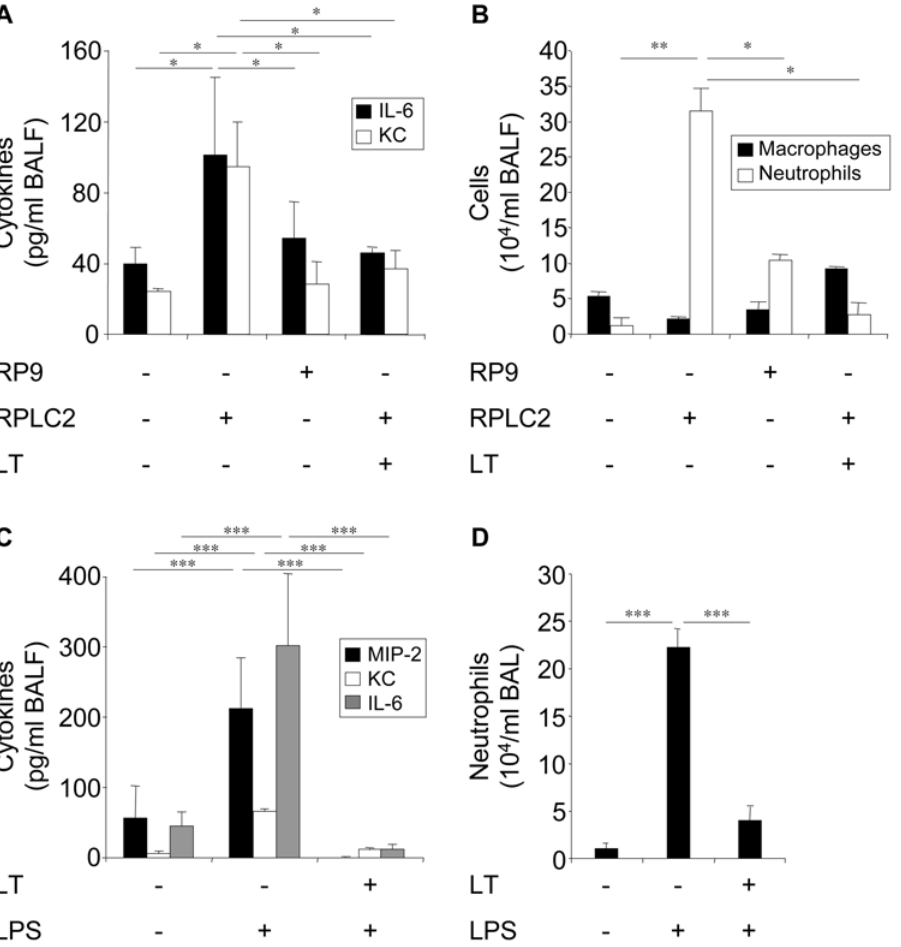
Figure 1. LT impairs pulmonary inflammatory response. (A,B) Mice received intratracheal instillation of LT (550 m g/kg) or saline 1 h before intranasal instillation of germinated RP9 or RPLC2 bacilli (10 7 cfu). Sixteen hours later, BALs were performed, then KC and IL-6 concentrations (A), and the numbers of PMN neutrophils (B) were measured. (C,D) Mice received intratracheal instillation of LT (550 m g/kg) or saline 1 h before intranasal instillation of LPS (330 m g/kg). Sixteen hours later, BALs were performed, and the concentrations of MIP-2, KC, and IL-6 (C) and numbers of PMN neutrophils (D) were determined.